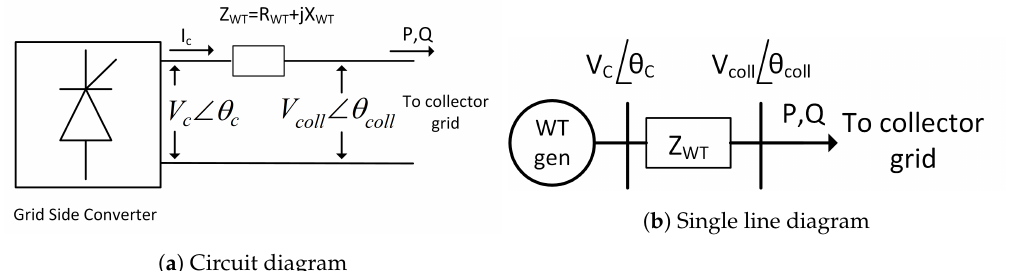
Figure 2. Equivalent representation of grid side converter (GSC) connected to WPP collection system through WT